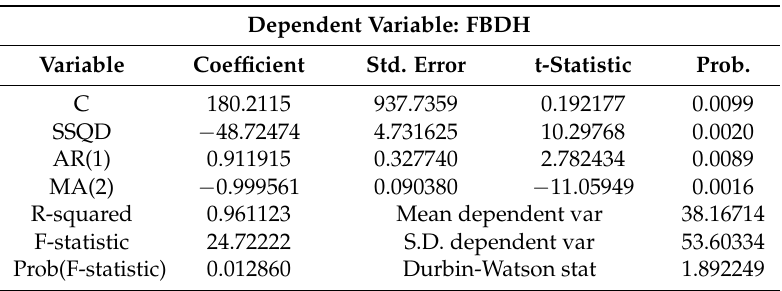
Table 12. Estimation results of the breakwater damage equation measurement